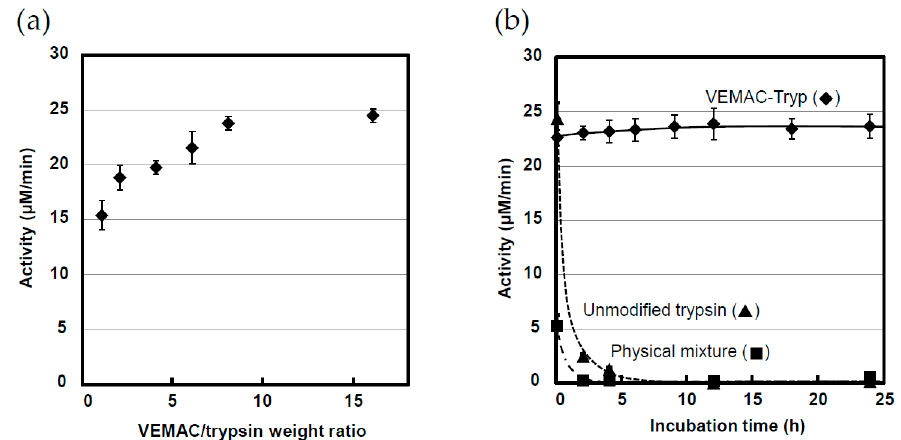
Figure 1. ( a ) Enzymatic activity of vinylmethylether-maleic acid copolymer (VEMAC)-Tryp synthesized using varying VEMAC/trypsin ( w / w ) ratios; ( b ) Enzymatic activity kinetics of VEMAC-Tryp, unmodified trypsin, and VEMAC/trypsin mixture incubated in phosphate buffer solution (50 mM, pH 8.0) at 37 ◦ C. Enzymatic activity was determined from the hydrolysis rate of benzoyl- DL -arginine p -nitroanilide hydrochloride catalyzed by trypsin. Data are shown as mean ± standard deviation ( SD ) ( n =